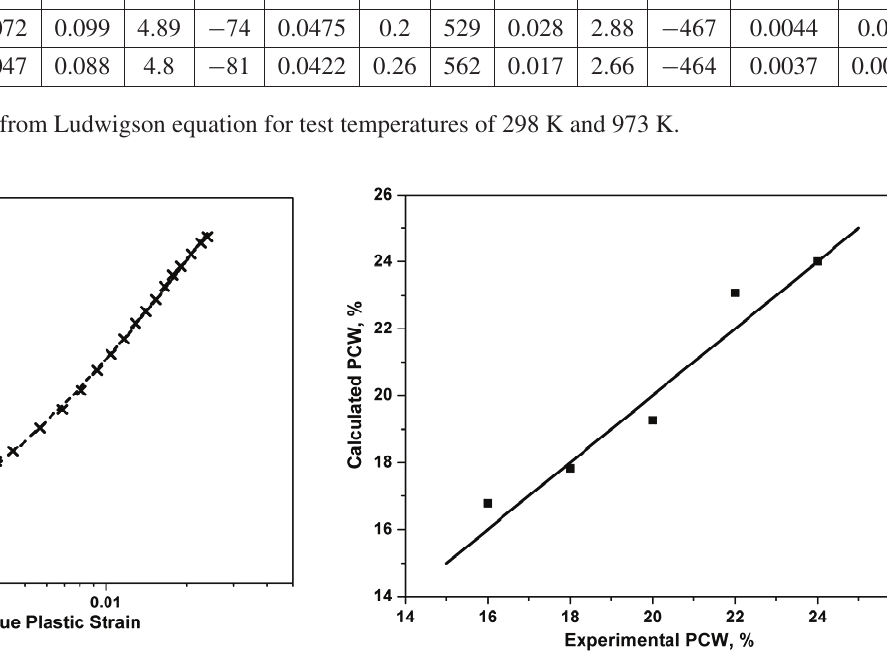
Comparison between actual PCW and the calcu- lated PCW using modified Swift